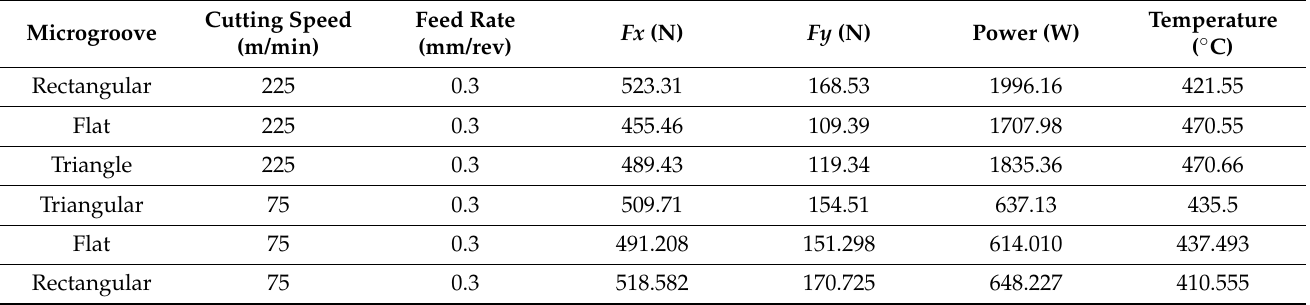
Table 11. Analysis of microgroove at different cutting speed and constant feed rate.